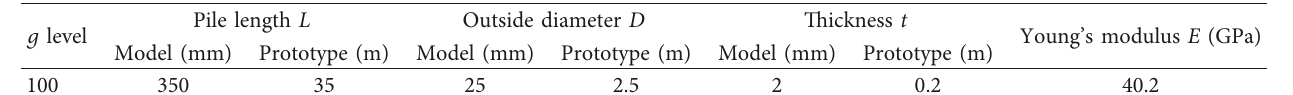
Table 3: Characteristics of test piles.